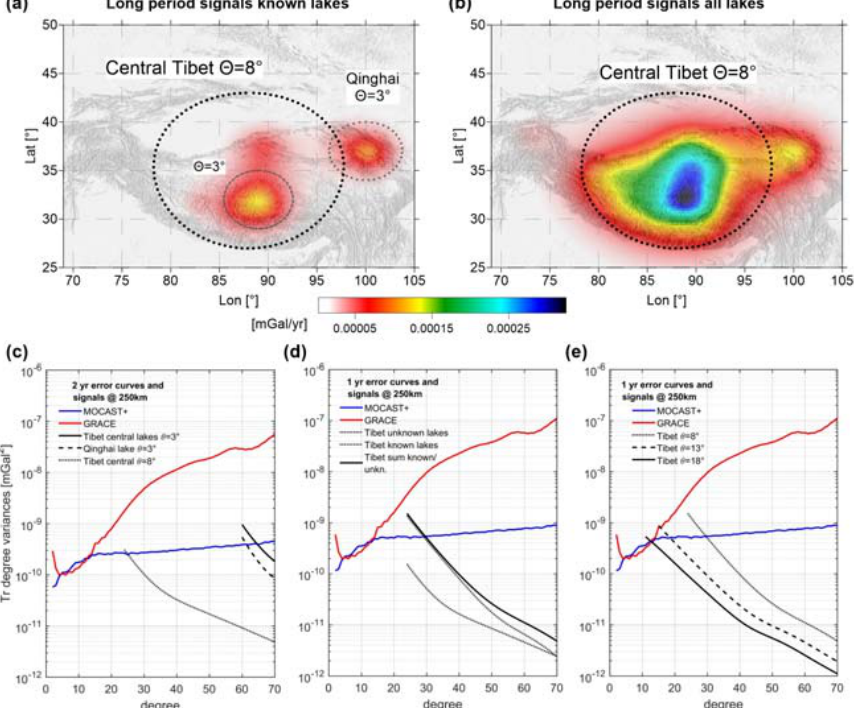
Figure 13. Gravity effects of the Tibetan Lakes at 250 km altitude. ( a ) Effect of only the lakes considered by the DAHITI database; ( b ) effect of all lakes. The dashed outlines mark the various spherical caps considered. ( c ) Spectra of long-period trends in the Tibetan lakes from the DAHITI database (black lines). The signal spectra are relative to the gravity change cumulated over 2 years. The 2-year error curves of MOCAST+ (blue) and GRACE (red). ( d ) Spectra of long-period trends for the cumulative effect of all the lakes of the Tibetan plateau (black lines. The 1-year error curve of MOCAST+ (blue) and 1-year error curve of GRACE (red). Rates expressed as the gravity change accumulated in one year. ( e ) Spectra of long-period trends in the Tibetan lakes as function of the localization window radius (grey and black lines). 1-year error curves of MOCAST+ (blue) and GRACE (red). Rates expressed as the gravity change accumulated in one year. All spectra calculated at 250 km altitude.